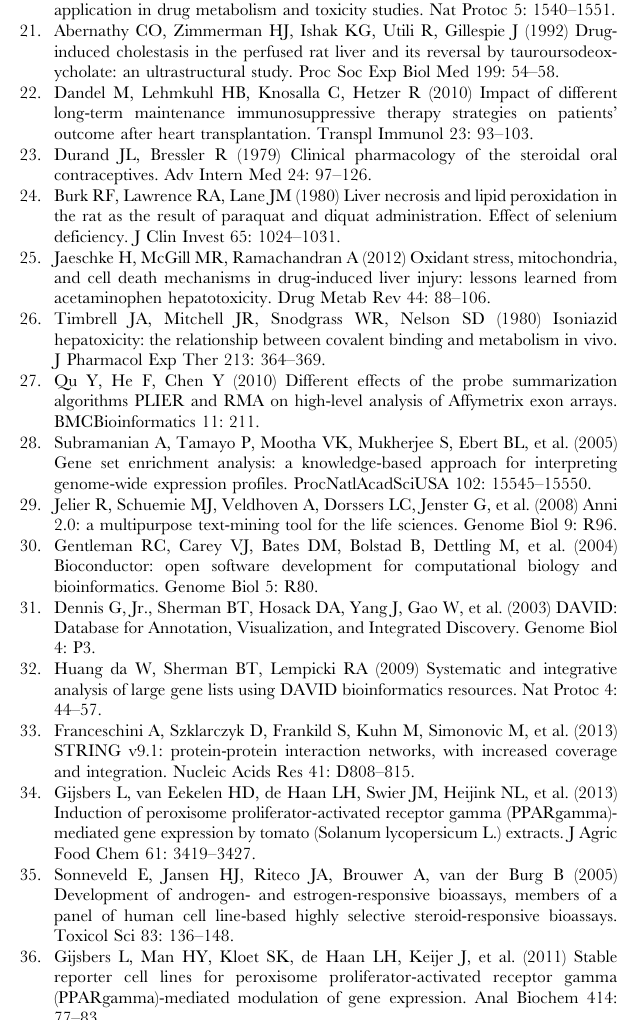
values and are expressed as means 6 standard errors (n= 3). X axis represents concentration of the tested compounds [M] and y axis represents luciferase units. Figure S5 Identification of candidate biomarkers for steatogenic drugs in mouse PCLS. To identify candidate biomarkers for steatogenic drugs, significant genes found by GSEA in precision cut liver slices (PCLS) treated with amiodarone (AMI), valproic acid (VA), and tetracycline (TET) were analysed by Venn diagrams. Eight overlapping, upregulated genes in PCLS treated with AMI and VA were considered as candidate biomarkers for PPARs agonists. Genes uniquely downregulated by TET (i.e. 77), were considered as candidate biomarkers for TET-like acting compounds. Table S1 ANNI gene sets. Gene sets related to diverse hepatic and non-hepatic functions were created in ANNI and were used in GSEA to detect major biological processes affected by treatment with amiodarone, valproic acid, and tetracycline.